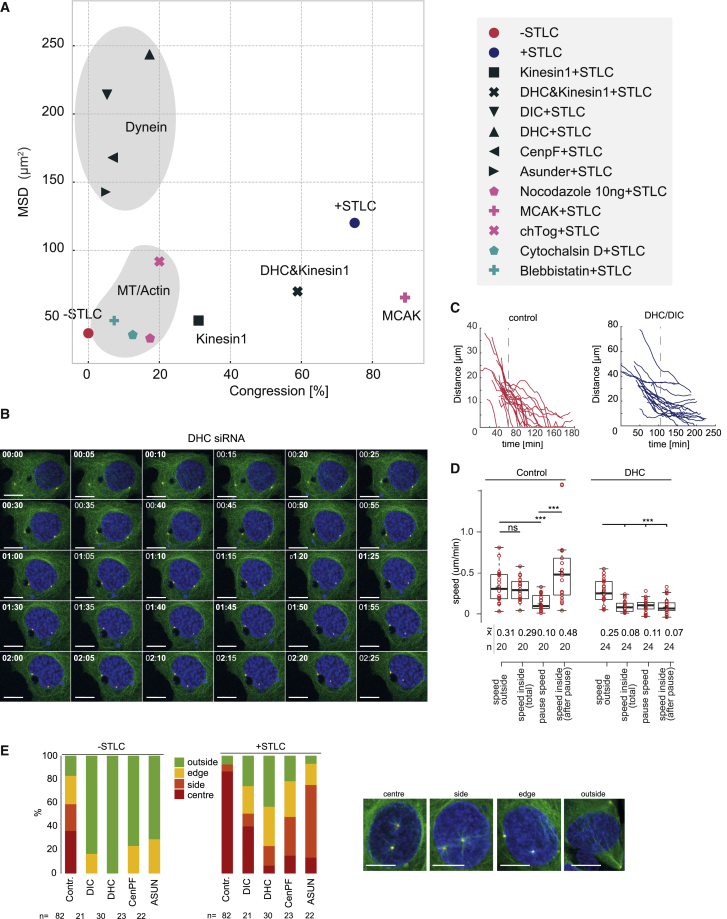
The Dynein/Kinesin-1 Balance Is Critical for Congression along the NE(A) Summary of MSD and congression data. Mean values of MSD (y axis) and percent congression (x axis) are plotted of all congression experiments performed in this paper. Dynein and MT/actin clusters are highlighted by gray areas. Individual data points are referenced in the figure legend to the right. See Figure S1 for confirmation of siRNA depletions.(B–D) Centrosome congression in DHC-depleted cells in cytoplasm and at the NE. (B) Images from time-lapse video of centrosome congression in DHC-depleted cells (green, GFP-α-tubulin; red, RFP-PACT; blue, Hoechst-33342-labeled DNA). Time is indicated in h:min on the top left, and scale bar represents 10 μm (see also Video S3). (C) Individual tracks of distance over time in control and DHC-depleted cells. Tracks are aligned along the time axes by the point of contact of both centrosomes with the nucleus. (D) Quantification of speed in the cytoplasm (outside) and nucleus (inside) 0–20 min after reaching the nucleus (pause) and t > 20 min after reaching the nucleus (after pause). See also Figure S2 for more data on dynein depletion and centrosome congression. p values were calculated using an independent two-sample t test. Levels of significance are indicated by stars (∗p < 0.05, ∗∗p < 0.01, ∗∗∗p < 0.001). The boxplot indicates median, first and third quartiles, and minimum/maximum values.(E) Qualitative analysis of centrosome position before and 2 h after STLC treatment following indicated siRNA depletions. Centrosome position was scored as indicated in color legend (n indicates the number of live-cell imaging sequences analyzed). Examples of positions are shown in images below (scale bar, 10 μm).